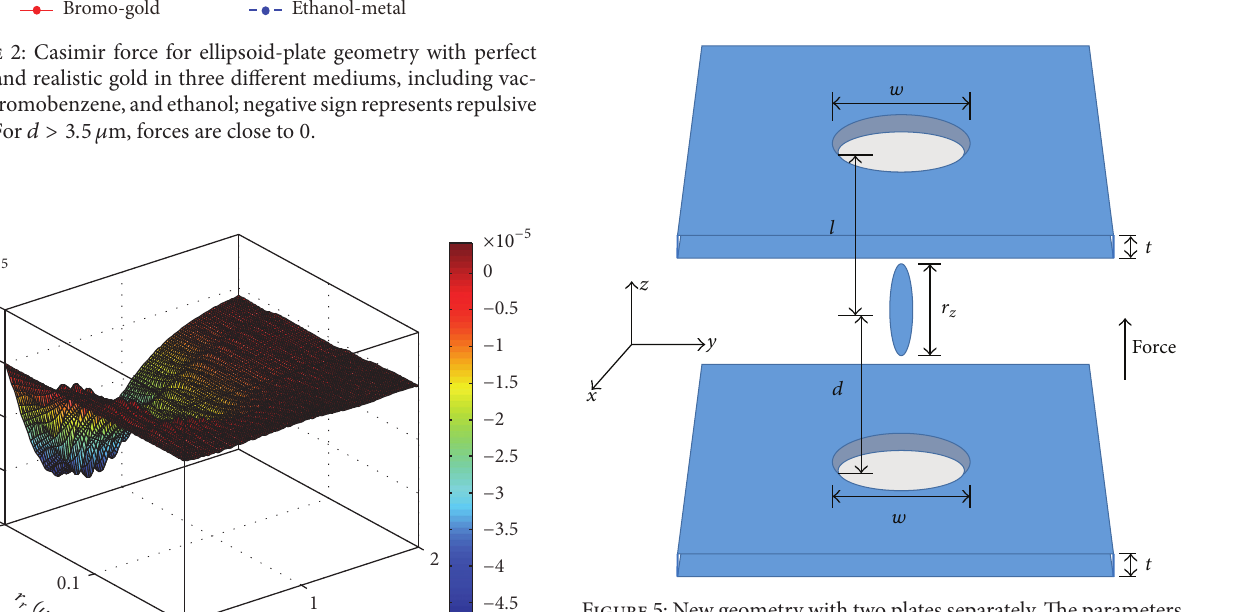
Figure 5: New geometry with two plates separately. The parameters are the same as the original geometry (see Figure 1), and the separation between the top plate and ellipsoid is 𝑙